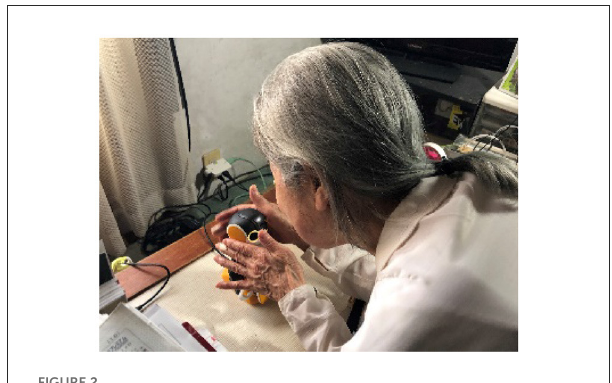
FIGURE2 Scene of an older adult treating the robot kindly and conversing with it at home.